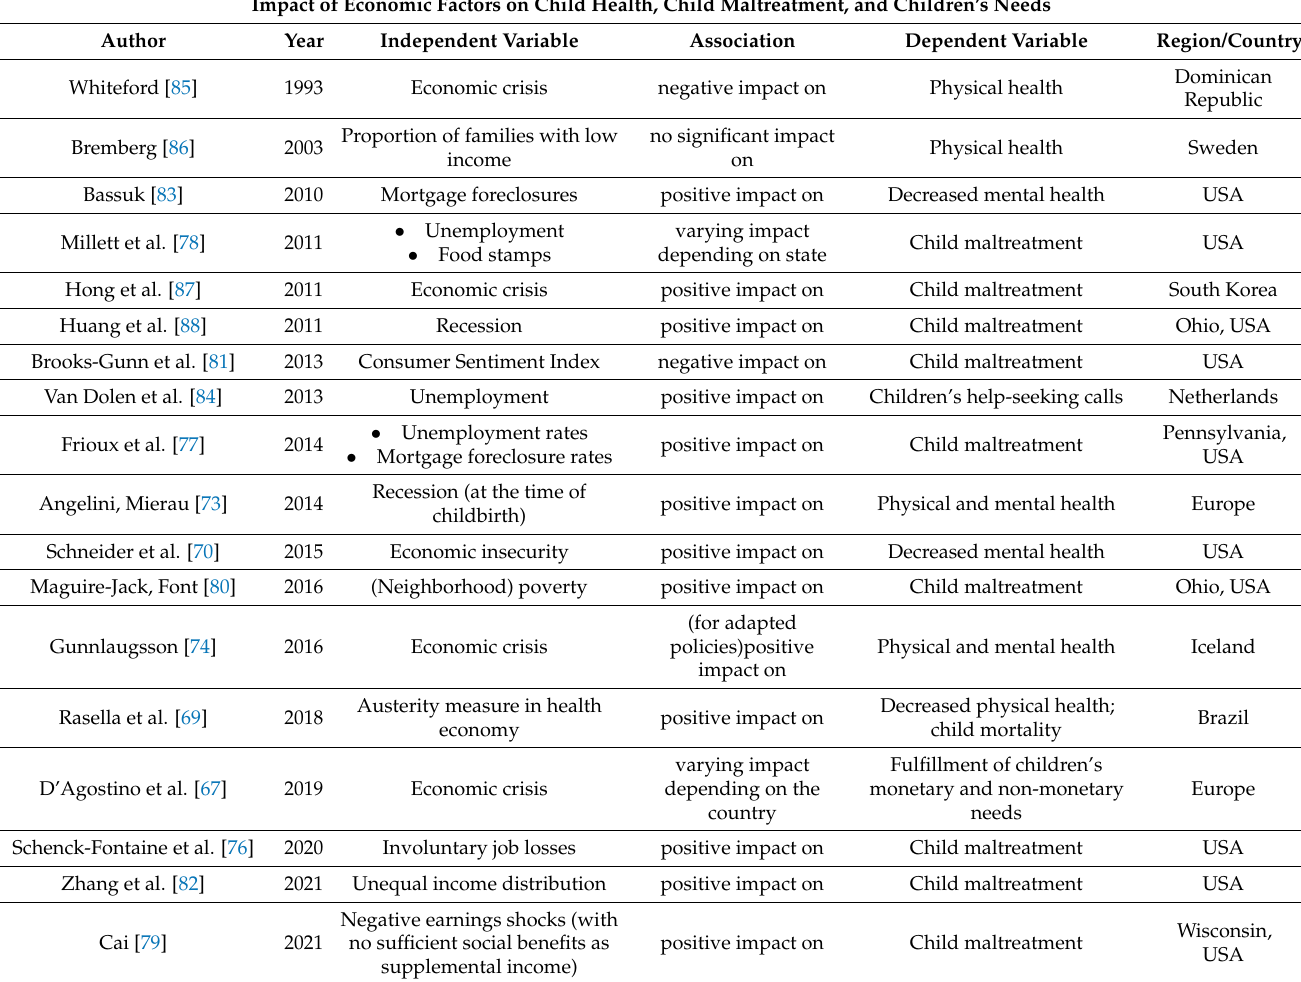
Table 1. Overview of studies on the impact of economic factors on child